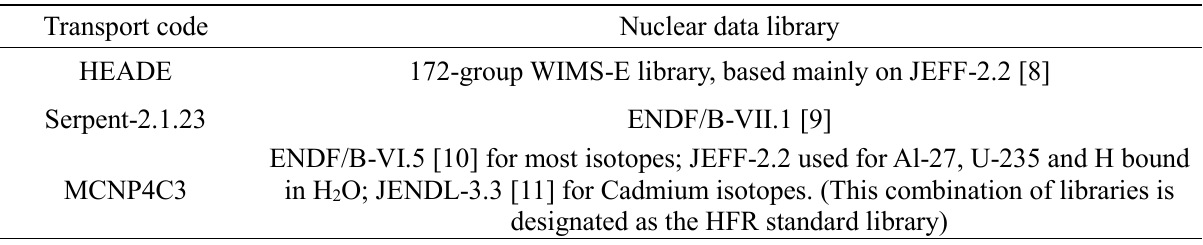
Table I. Nuclear data: Transport codes and their associated libraries used during cross section